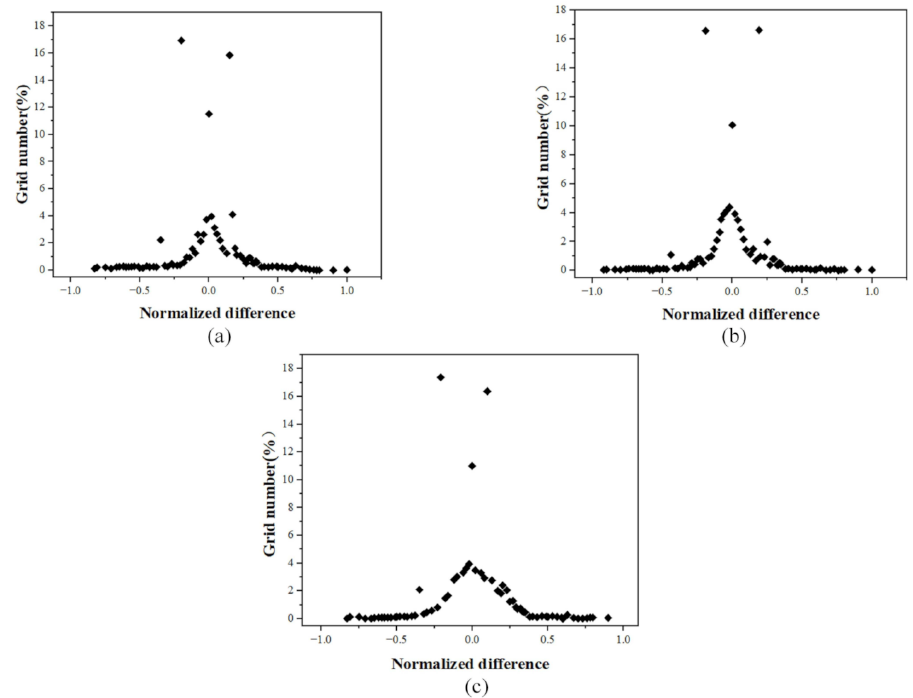
Figure 10. Point cloud distribution difference between the reconstructed model in each iteration and the reference individual tree model. ( a ) First iteration; ( b ) Second iteration; ( c ) Last